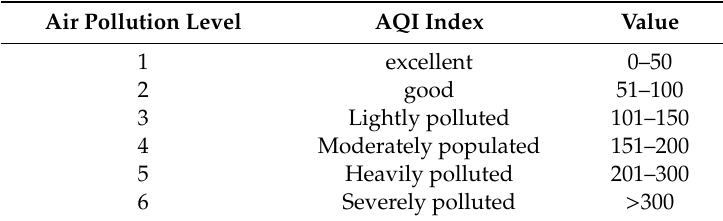
Table 1. Classification of the AQI index.